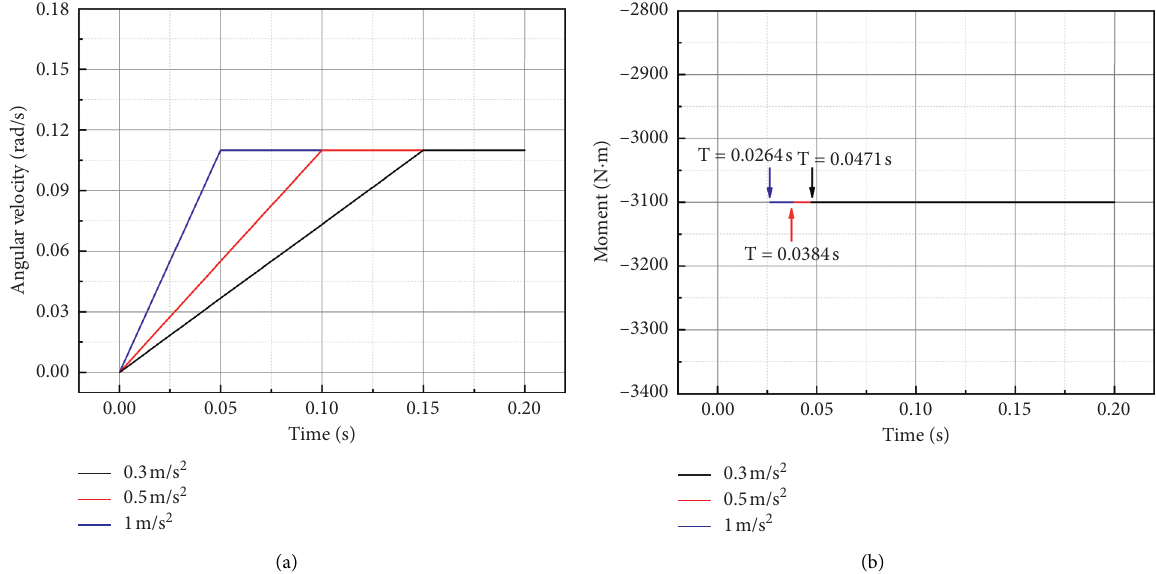
Figure 7: The load curve of axle spline and wheel spline. (a) The inner surface of axle spline load curves. (b) The outer surface of wheel spline load